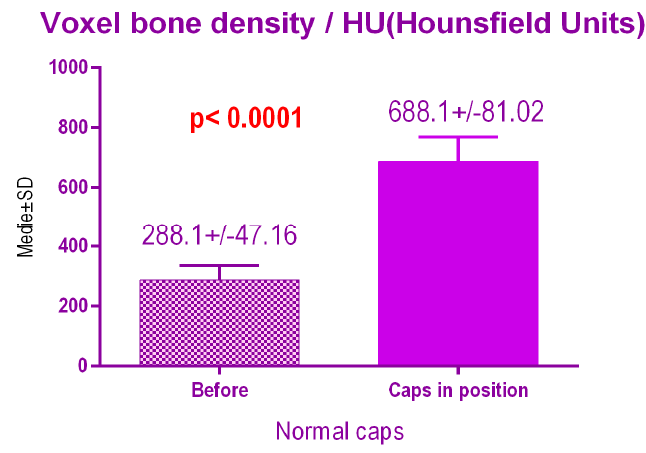
Figure 14. Bone radiodensity after conventional healing caps.